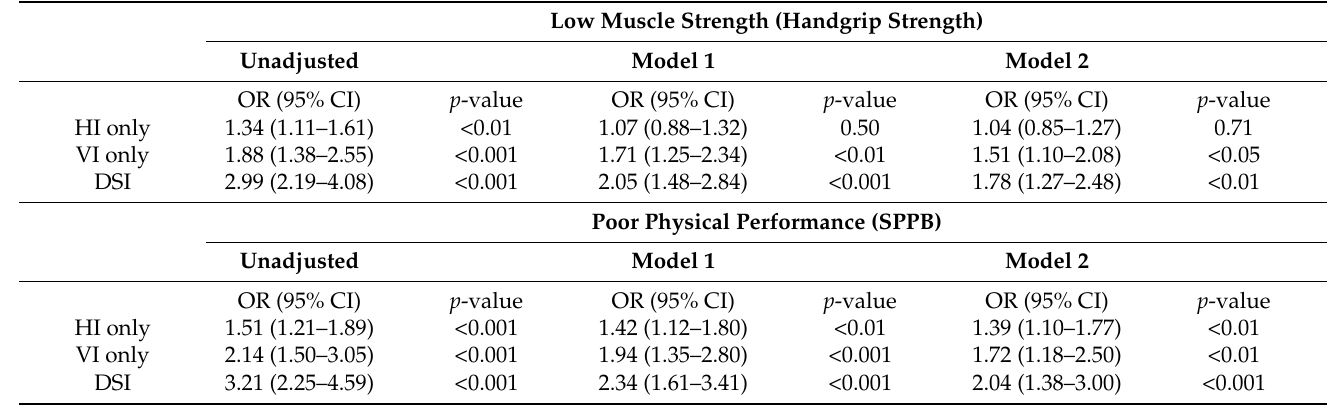
Table 3. Association between sensory impairment and low physical function (cross-sectional analysis). Low Muscle Strength (Handgrip Strength)